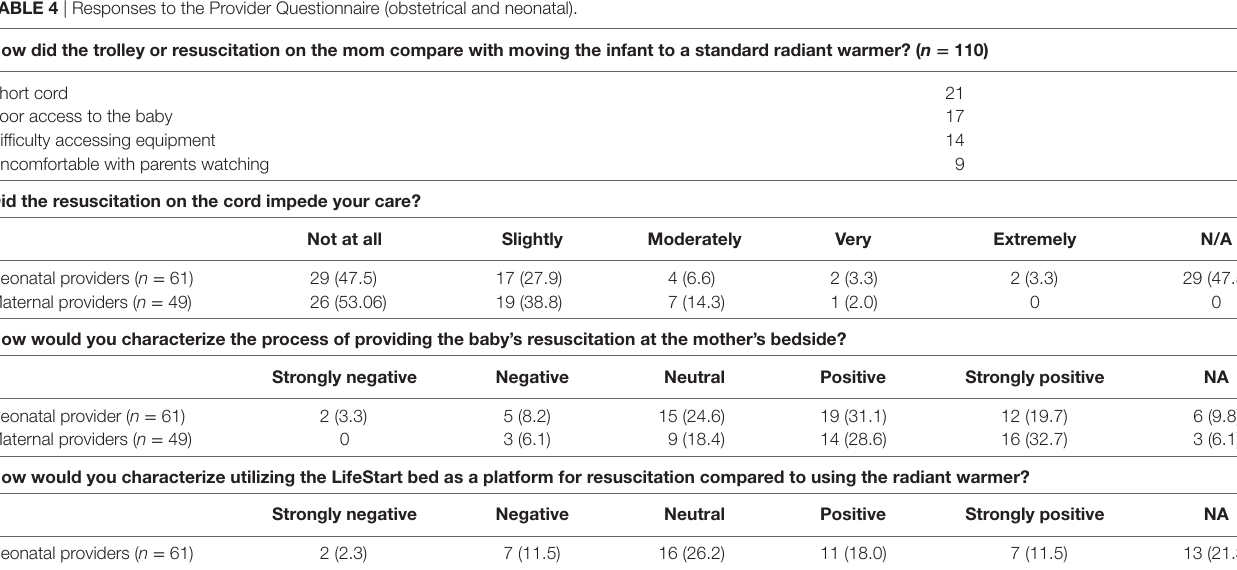
TaBle 4 | Responses to the Provider Questionnaire (obstetrical and neonatal).